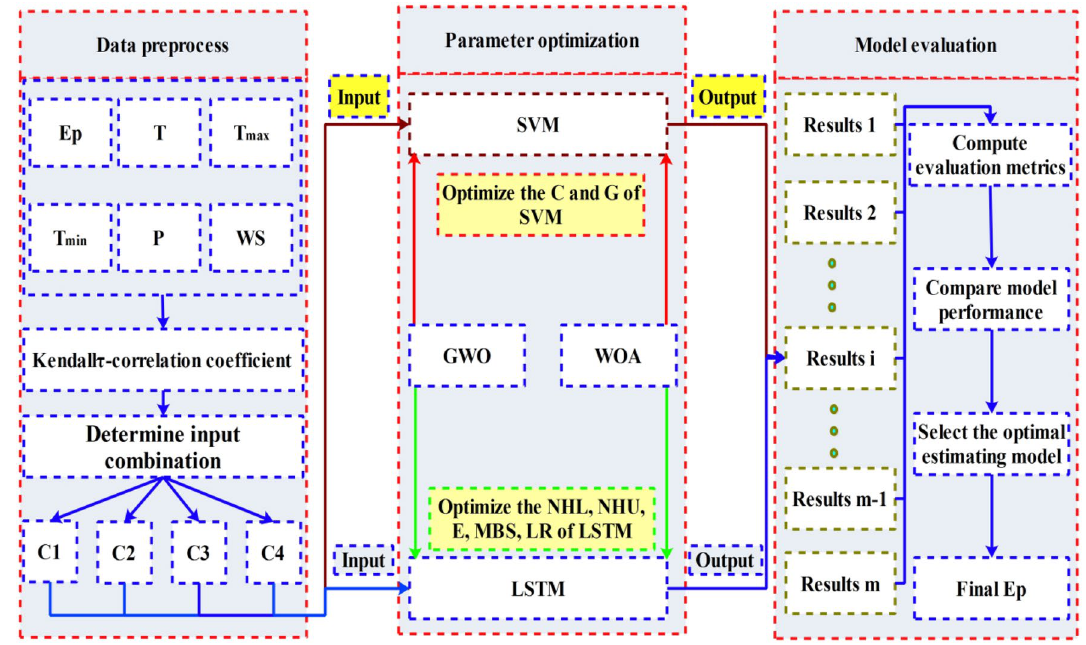
Figure 4. The flow chart of the estimating